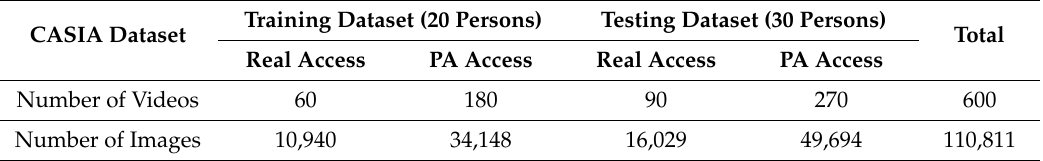
Table 4. Description of the original CASIA dataset used in our experiments.